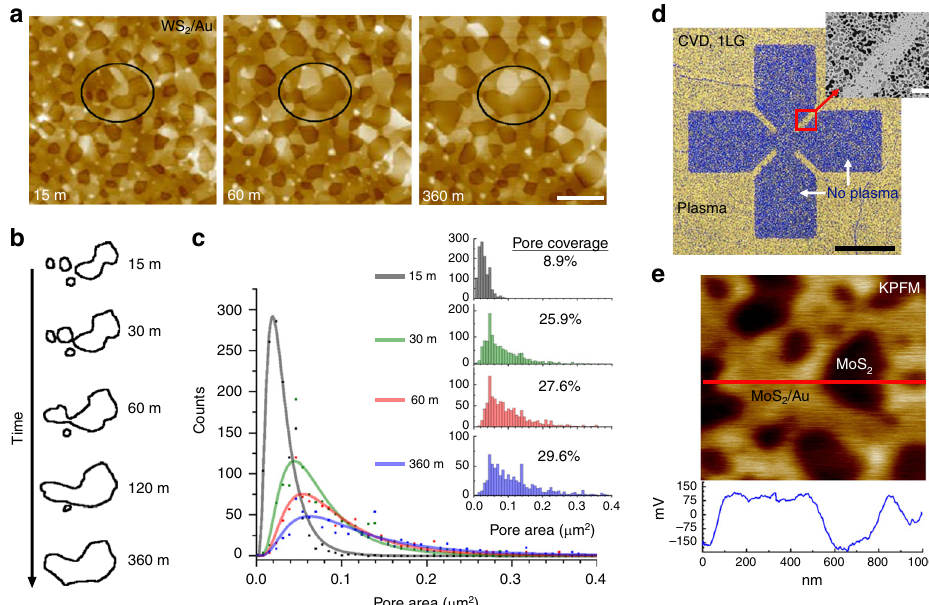
Fig. 2 Evolution of 2DC/Au/SiO 2 samples during annealing. a Series of AFM images from the same monolayer-WS 2 /Au region after different cumulative annealing times (Ar + H 2 , 300 °C; scale bar = 1 μ m) (note: optical images of this region shown in Fig. 3d). b Outline of the pores inside the black ovals in a with increasing annealing time. c Plot showing the histogram peak value of the pore area vs. count for different cumulative annealing times (processed using ImageJ 40 ). The solid lines are fi ts using the LSW particle-ripening model 26 . (inset) Full histograms of the pore area vs. count for different cumulative annealing times, along with the measured areal pore coverage for each annealing time. d Optical image showing a CVD graphene/Au/SiO 2 sample that has been selectively treated with a 15 sec O 2 -plasma (scale bar = 40 μ m). After annealing, the Au layer beneath pristine graphene dewets, while the Au beneath O 2 -plasma exposed graphene has limited dewetting (inset scale bar = 3 μ m) e KPFM image of a MoS 2 /Au sample after annealing. The suspended MoS 2 membranes can have up to a 300 mV potential difference compared to the Au-supported MoS 2